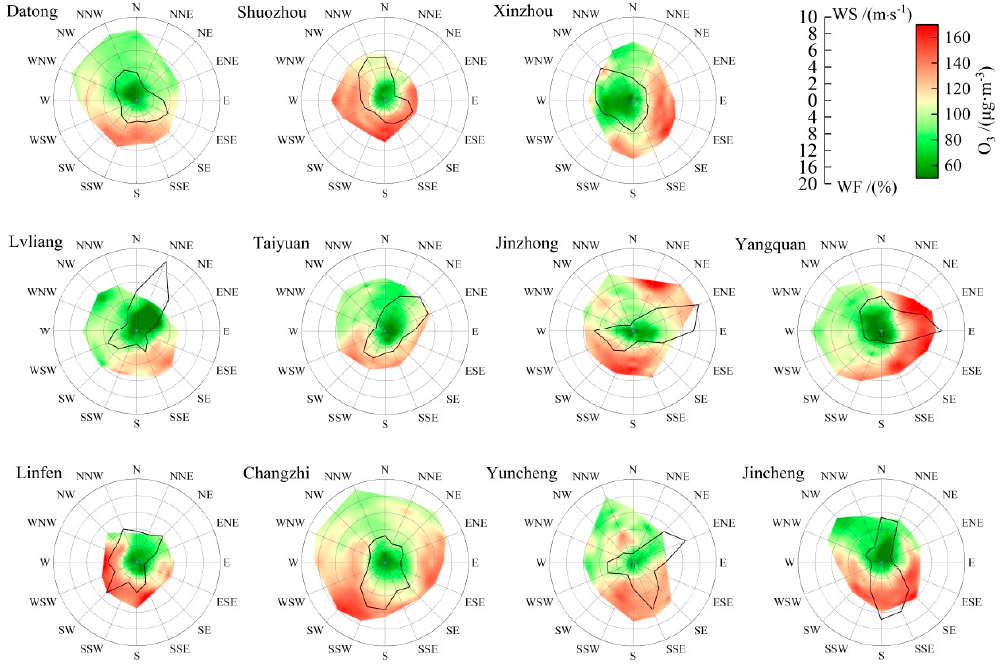
Figure 12. Distributions of O 3 mass concentration at different wind directions, wind speeds and wind frequencies in 11 cities of Shanxi Province during the time period from May to August. Low surface O 3 in most cities in Shanxi was associated with northern wind, while O 3 was generally high with southern wind, which may be related to upwind O 3 content [66]. Except for the northern wind in Shuozhou and Linfen, low wind speeds in the other wind directions corresponded to high O 3 , which reflected the high capacity of local photochemical reactions. In Xinzhou, Yangquan and Lvliang, low wind speed corresponded to low O 3 , while O 3 was obviously higher under certain wind directions, indicating that O 3 pollution in these three cities was caused by regional transport to a great extent. Among the wind directions, O 3 under the southeast wind was significantly higher than in other directions in Xinzhou; the high − level O 3 mainly came from transport in the southeastern direction, but the frequency of wind from that direction was relatively small, so there was only a slight influence of southeast transport on annual mean O 3 . The distribution characteristic of high O 3 in Yangquan was similar to Xinzhou, mainly transported from the east, and due to the high frequency of wind from this direction, O 3 pollution easily occurred and increased the annual mean O 3 . Lvliang was affected by transport from the southeast direction. In Datong, Taiyuan, Jinzhong, Changzhi, Yuncheng and Jincheng, high O 3 occurred under low wind speeds from each wind direction, and the southern wind corresponded to high O 3 in these cities, indicating that O 3 pollution was caused by the combined actions of local photochemical reactions and regional transports. Surface O 3 pollution in Datong was greatly affected by transport from the southern direction. High O 3 was associated with the southern wind in Taiyuan; wind speed and frequency in this direction were low, suggesting that local generation in Taiyuan accounted for a large proportion of surface O 3 pollution. High O 3 was usually found under low wind speed in Jinzhong, and O 3 pollution occurred when the region was affected by transport from the northeast and southwest. Wind speed in each direction was higher in Changzhi, and O 3 pollution was prone to happen under transport from the southwest and east. Yuncheng O 3 pollution was mainly influenced by transport from the southern region. High O 3 occurred under low wind speed in Jincheng, and O 3 pollution increased when the region was affected by transport from the south and southwest. As